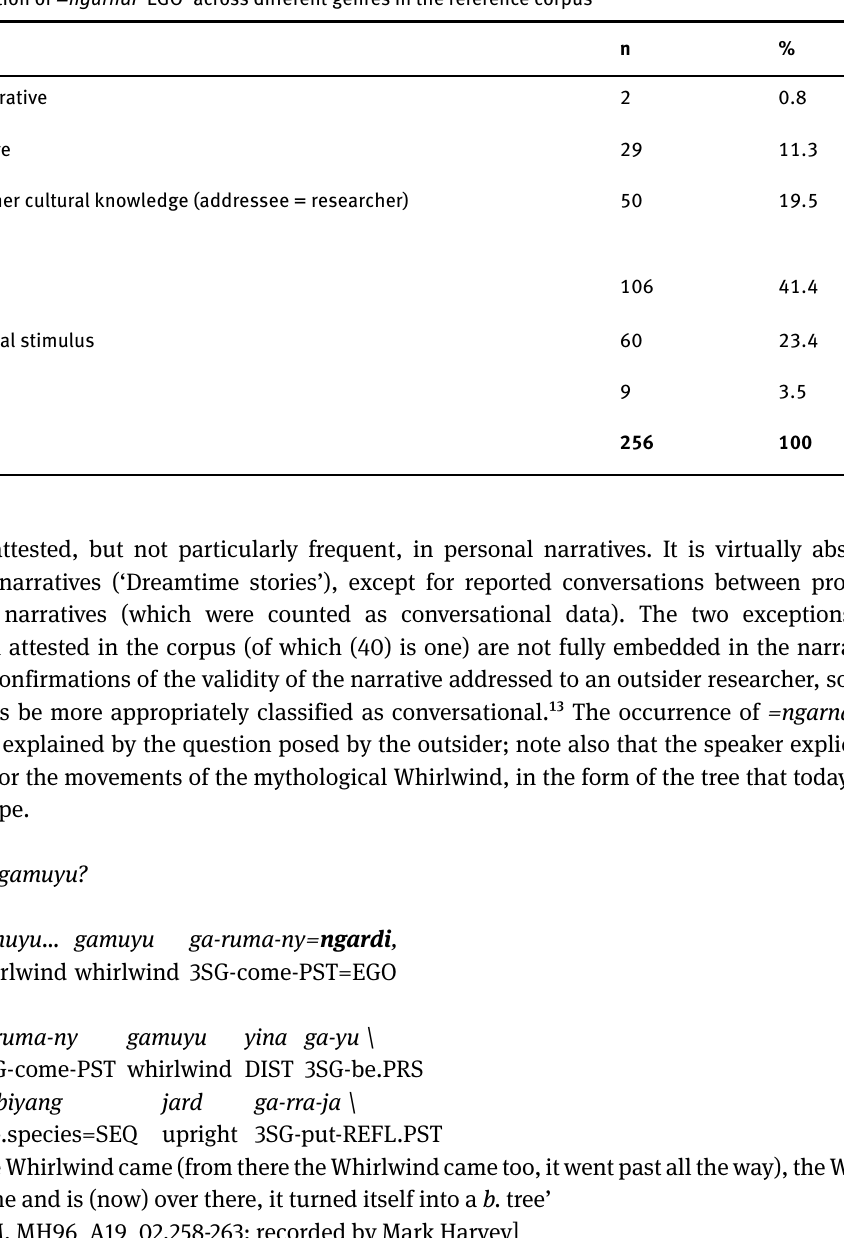
Table 2 : Distribution of =ngarndi ‘EGO’ across different genres in the reference corpus